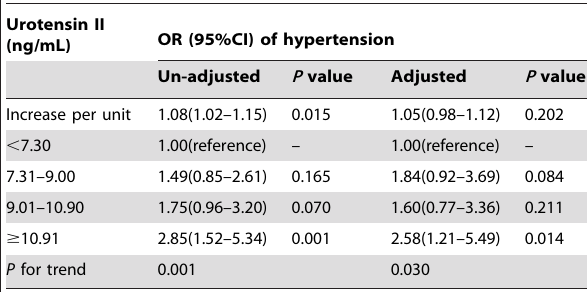
Table 2. Odds ratio and 95% confidence interval of hypertension associated with different plasma urotensin II levels.